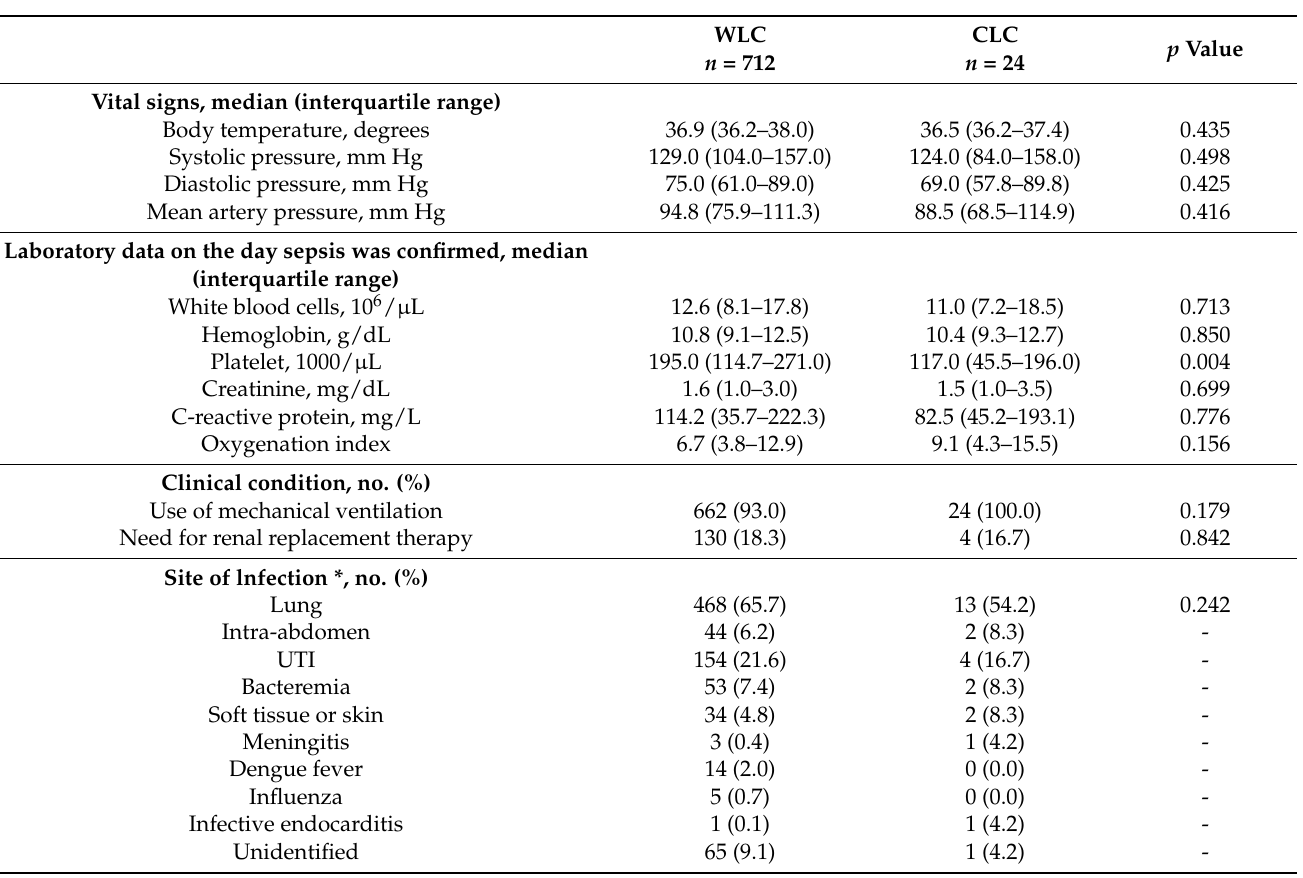
Table 2. Physiological and laboratory characteristics between the without liver cirrhosis group and the compensated liver cirrhosis